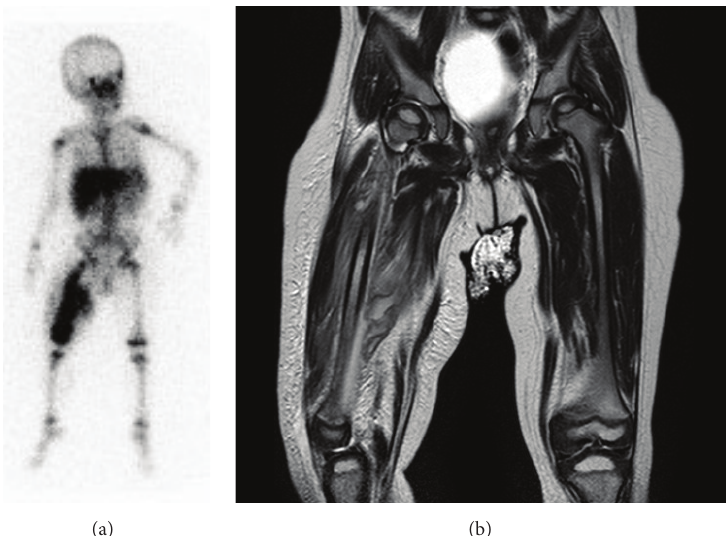
Figure 3: Gallium-67 citrate scintigraphy showing isolated uptake of the right femur (a) and magnetic resonance imaging scans of the right femur showing osteomyelitis with necrotizing fasciitis (T2-weighted image). There are signal changes in the diaphyseal region of the femurs with circumferential soft tissue involvement